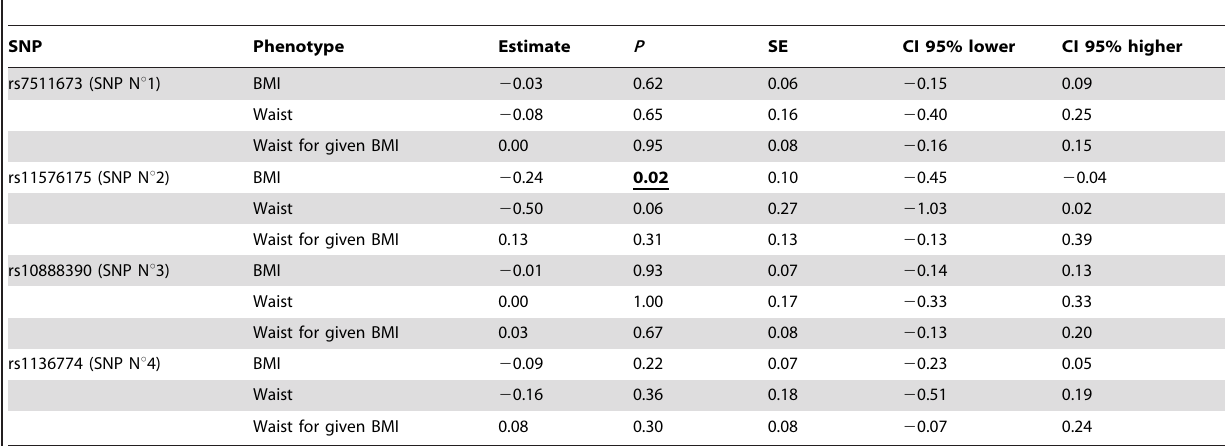
Table 3. Associations between CTSS SNPs, BMI and body fat distribution at baseline.